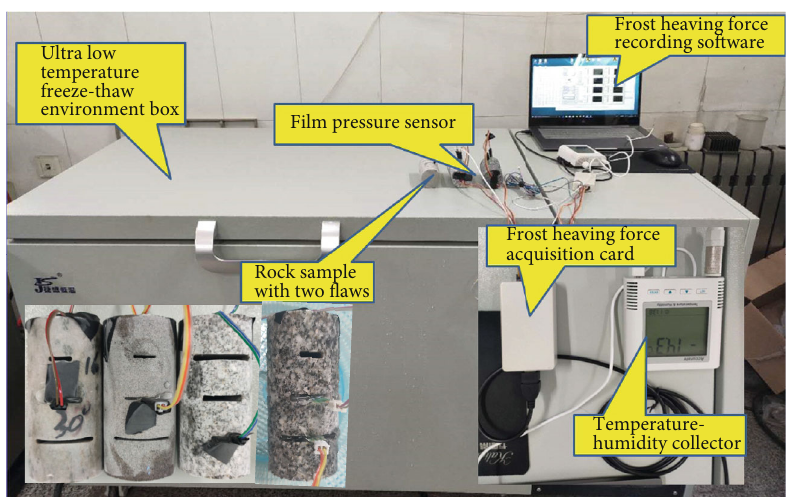
Figure 4: The frost heaving force measurement system developed in this work.